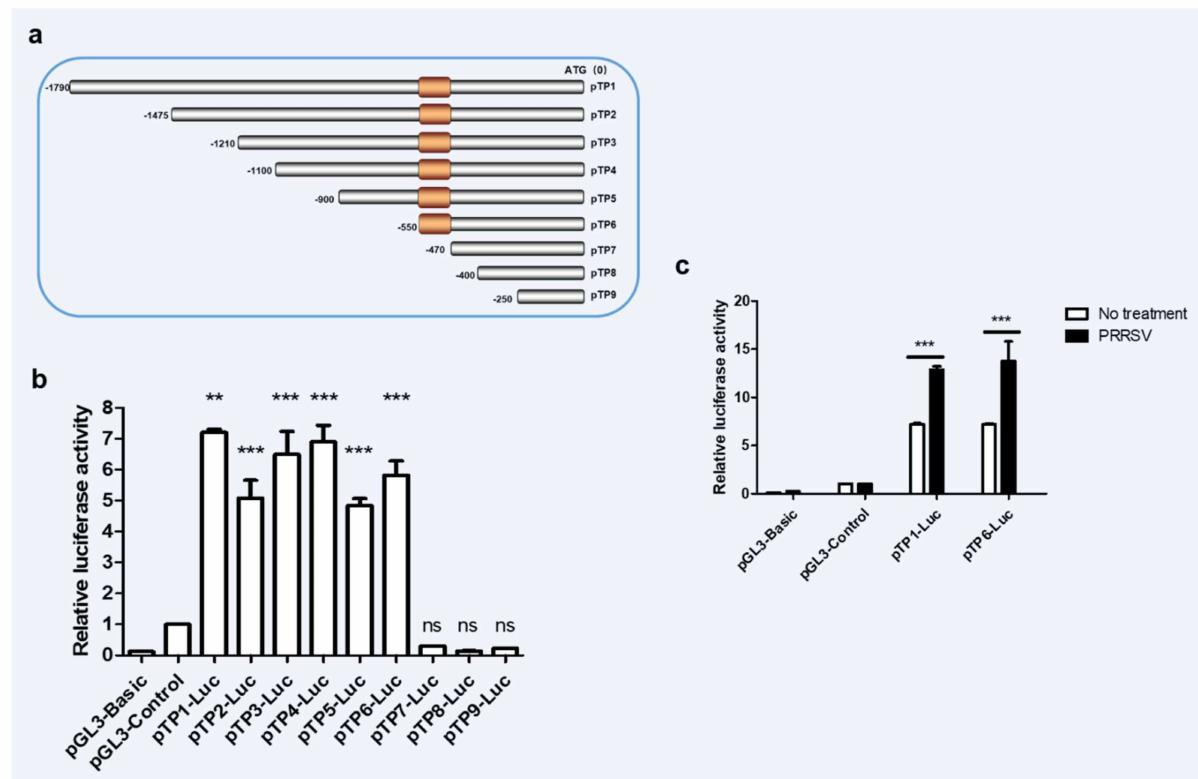
Figure 2. The core promoter region of porcine RNF22 was identified. ( a ) Schematic diagram of constitution of luciferase mutant plasmid. ( b ) HEK293 T cells were co-transfected with Luciferase mutant plasmid and RL-TK, luciferase activity was measured using the supernatant of lysate cells. ( c ) HEK293 T cells were co-transfected with pTP1-Luc, pTP6-Luc and RL-TK, infected with PRRSV (MOI = 0.5) or not, luciferase activity was measured using the supernatant of lysate cells. pGL3-Basic was the negative control and pGL3-Control was the positive control. ** p < 0.01; *** p < 0.001 ns, no significant difference (analysis of two-way ANOVA attended by Bonferroni post-test). Data are representative of three independent